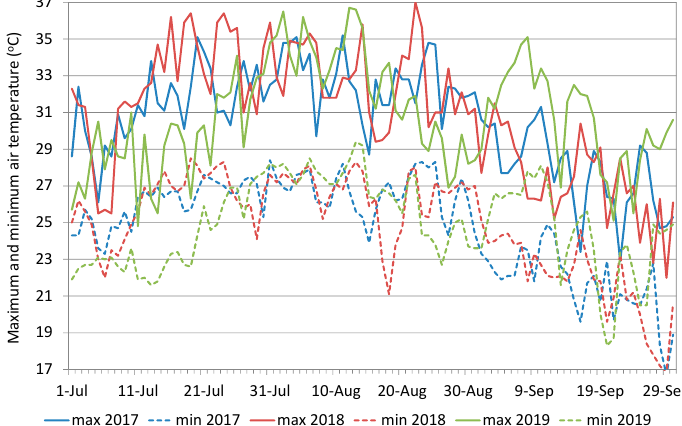
Figure 1. Daily maximum and minimum air temperature in Kobe city, from July to August, 2017 to 2019.